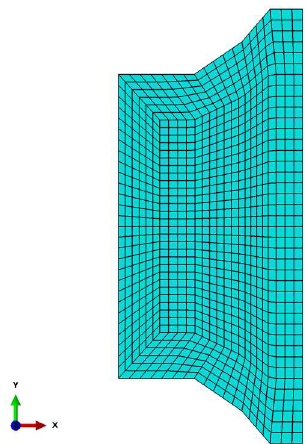
Figure 7. Finite element (FE) model of the designed welded joint.